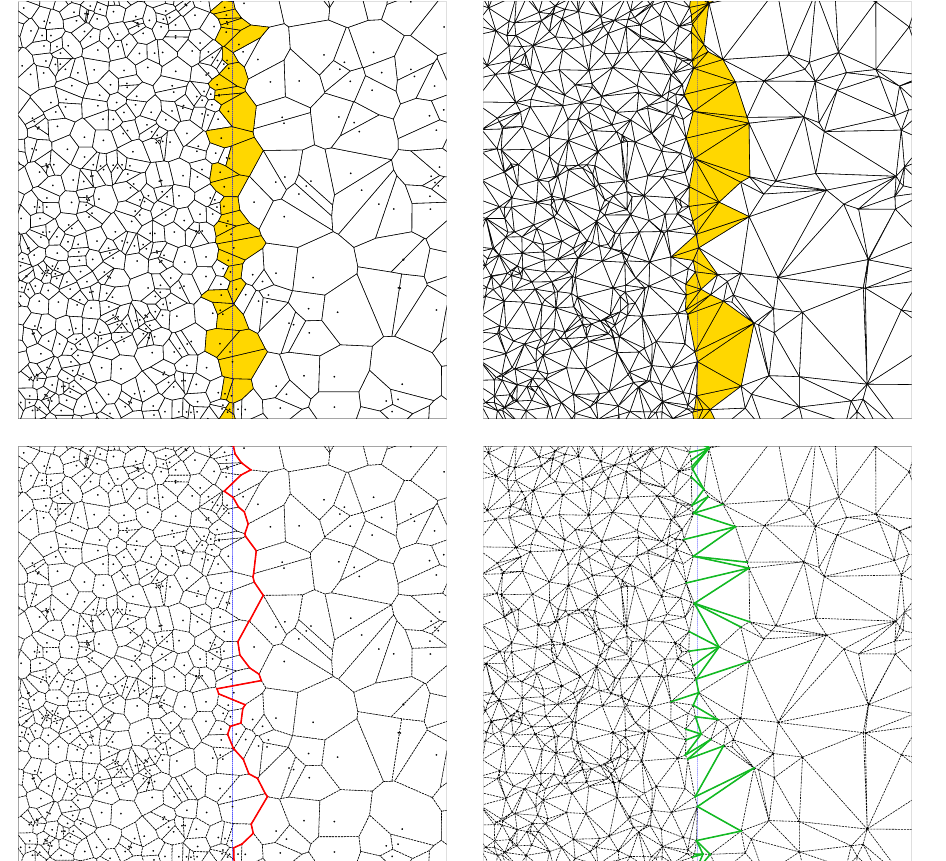
Figure 3 . The Voronoi and Delaunay tessellations of a typical point data distributed according to eq. (2.5) with N = 500 and ρ = 4 . The left (right) panels show the Voronoi (Delaunay) tessellation. The vertical blue dashed line marks the theoretical boundary line at x = 0 . 5 . The yellow-shaded cells in the top panels illustrate the boundary cells defined in section 2.3 for the Voronoi and Delaunay case, respectively. In the bottom panels, the tessellations are outlined with dotted lines while the solid lines represent the boundary Voronoi edges (red lines) and their dual Delaunay edges (green lines) as defined in section